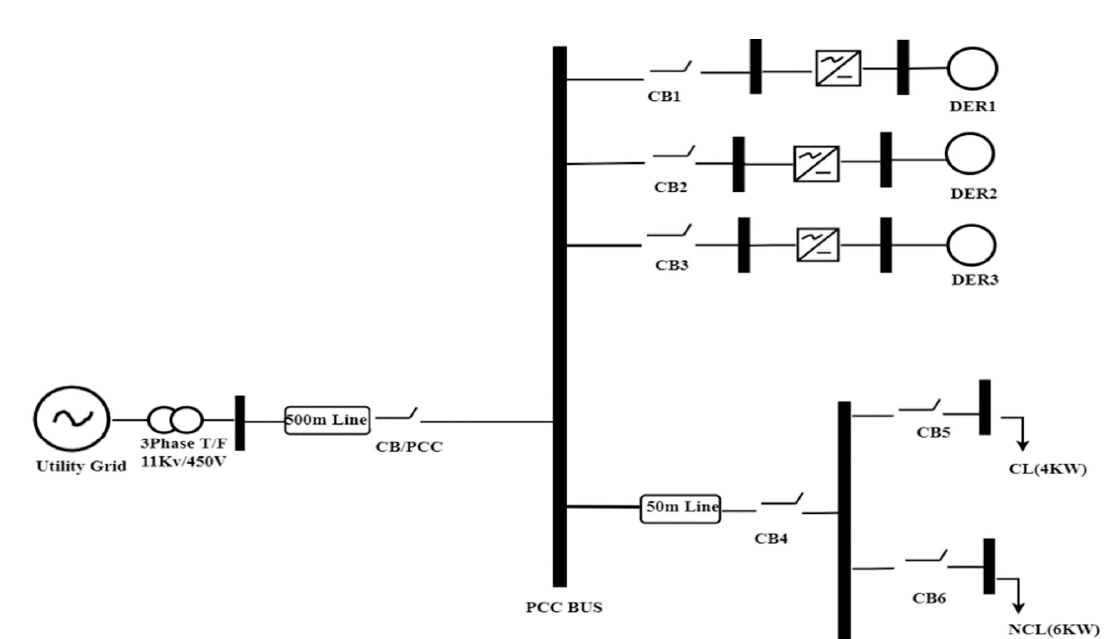
Figure 4. A miniature MG structure with additional line impedance.